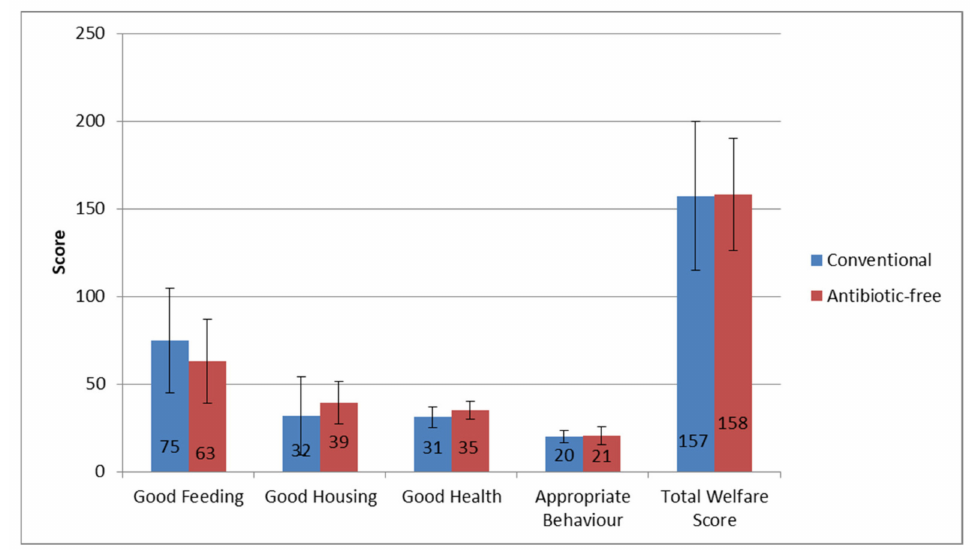
Figure 2. Mean scores assigned to each of the four welfare principles and average total welfare score calculated in conventional (blue) and antibiotic-free (red) batches. Standard deviation bars are reported.